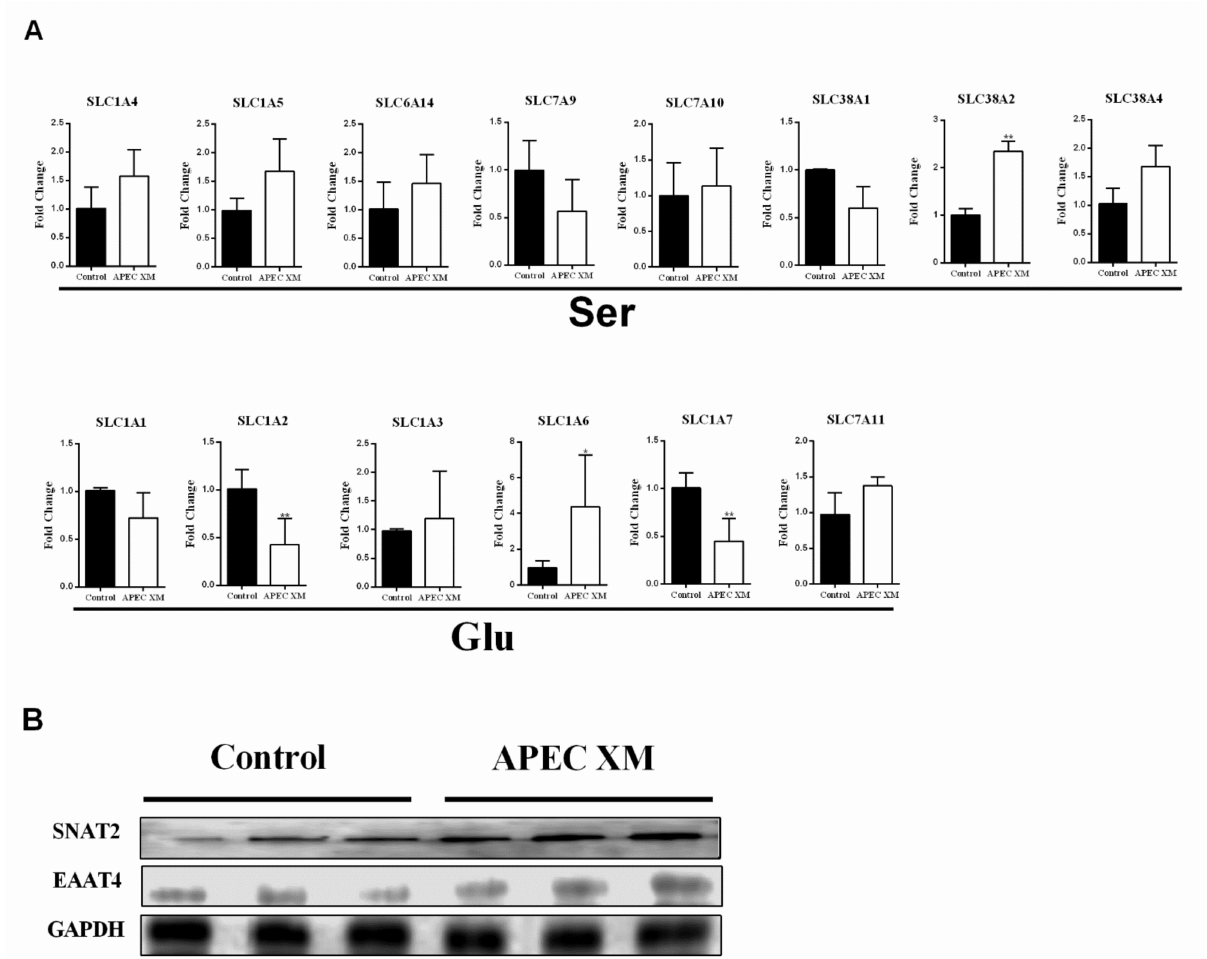
Figure 2. APEC XM infection upregulates the expression of SNAT2 and EAAT4. ( A ) RT-PCR validation of the expression of slc1a1 , slc1a2 , slc1a3 , slc1a4 , slc1a5 , slc1a6 , slc1a7 , slc6a14 , slc7a9 , slc7a10 , slc7a11 , slc38a1 , slc38a2 and slc38a4 in bEns.3 cells at 1 h post-infection. GAPDH was used as the reference control. Data are from one experiment representative of three independent experiments, with six replicates per group. Data represent means ± SD. * p < 0.05, ** p < 0.01. ( B ) Western blotting showed the significant upregulation of SNAT2 and EAAT4 in bEnd.3 cells at 1 h post-infection. The GAPDH was used as the loading